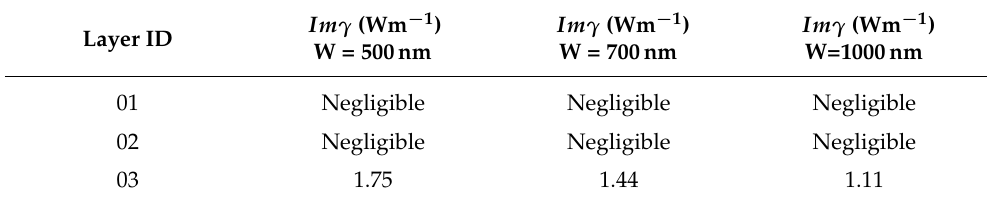
Table 4. Im γ coefficients measured by means of pulse-transmission experiments for different Si-rich SiN layer compositions and different waveguide widths. Reprinted, with permission, from [41], ©2019